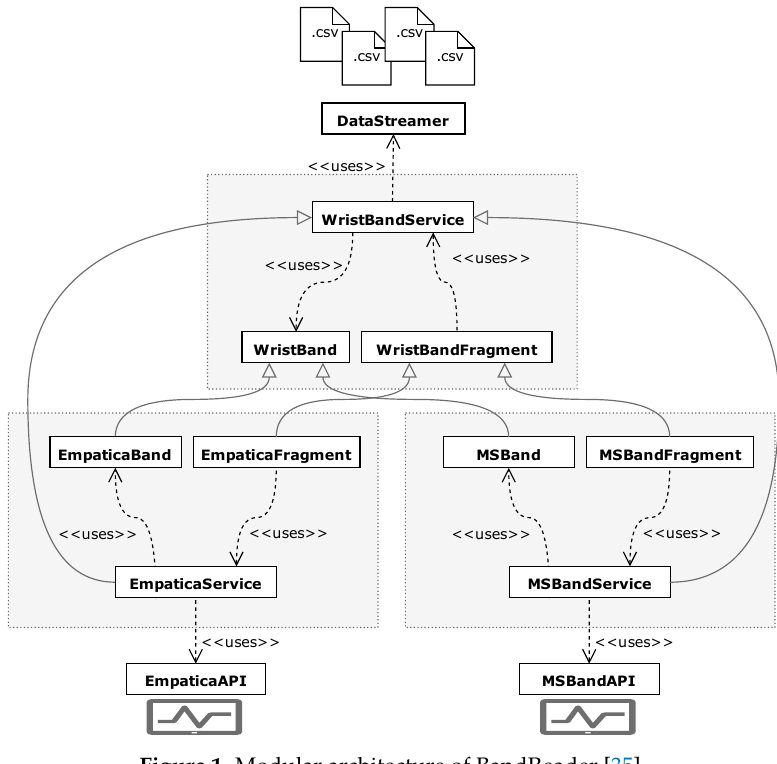
Figure 1. Modular architecture of BandReader